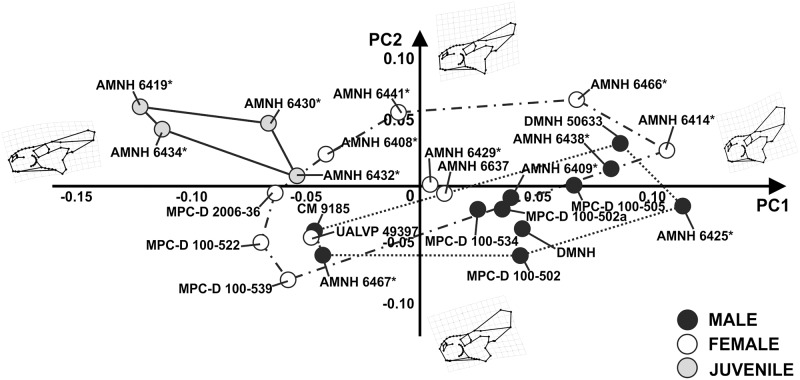
Principal Component Analysis performed on the skulls in lateral view.The continuous line represents “juvenile” morphospace. The dotted line represents “male” morphospace and the dashed line represents “female” morphospace. Asterisks indicate specimens shared with Dodson [25].